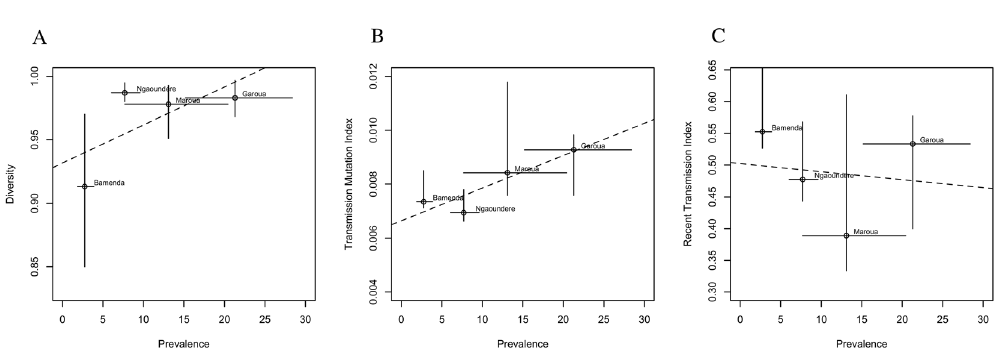
Figure 5. Bivariate plot of the abattoir based prevalence of M. bovis and ( A ) diversity, ( B ) the transmission mutation index)- (TMI) and ( C ) the recent transmission index-(RTI in the four abattoirs sampled between 2012–2013 in Cameroon. (B = Bamenda; N = Ngaoundere, G = Garoua, M =